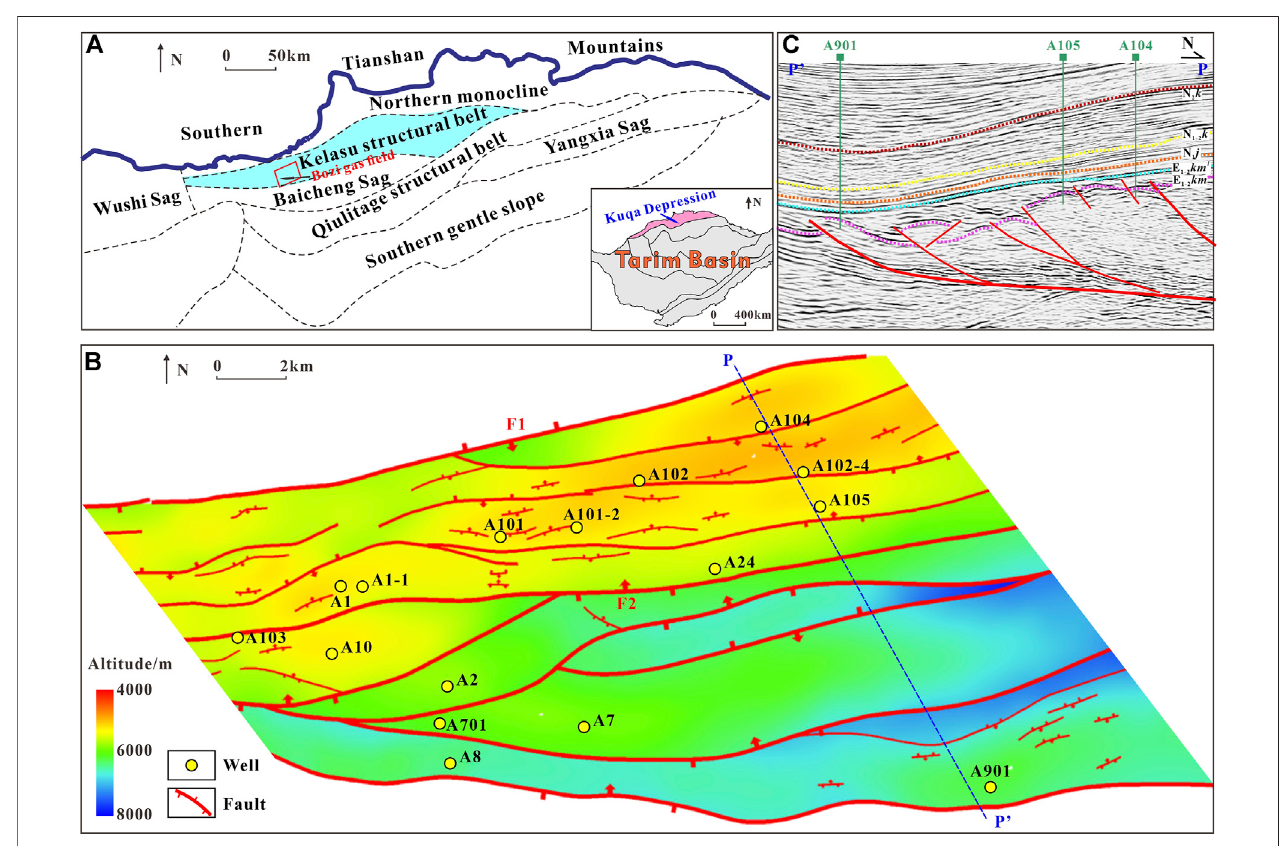
FIGURE 1 | Field location, seismic pro fi le, and top structure of the target layer in the Bozi gas fi eld. (A) The Kuqa Depression is the northernmost fi rst level unit in Tarim Basin. The Kuqa depression can be further divided into seven secondary tectonic units. The Kelasu tectonic belt is located in the second-row structure from the north,andtheBozigas fi eldislocatedinthewestoftheKelasutectonicbelt; (B) theCretaceoustopstructuremapoftheBozigas fi eldcomprisesseveralrowsoffaulted anticline structures divided by thrust faults. The strike of the anticline structure is basically the same, which is in the NE – SW direction; and (C) the typical thrust imbricate structure and pop-up structure of the Bozi gas fi eld can be seen through the seismic section of PP ’ .